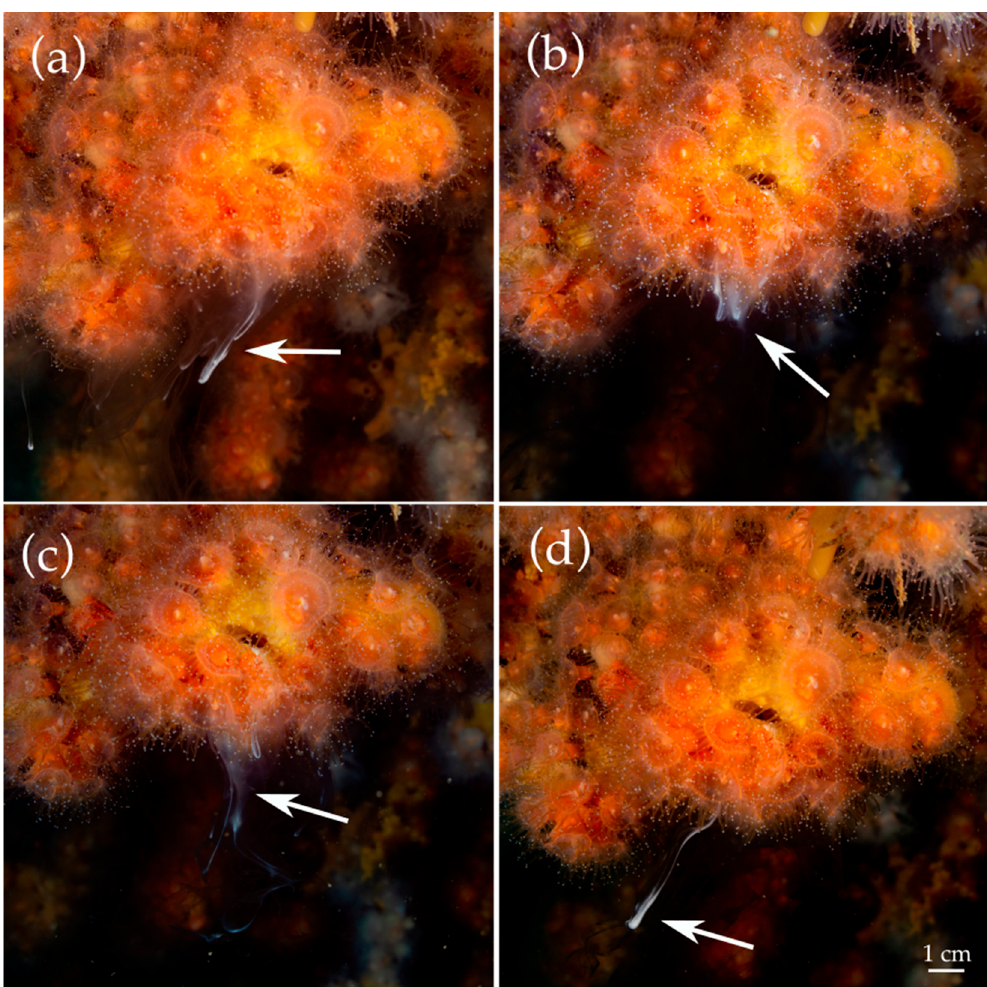
Figure 1. Sperm release by Corynactis carnea . The sequence ( a – d ) shows a group of specimens with at least one male releasing a dense cloud of sperm into the water. The arrow points to the cloud of sperm in each image.